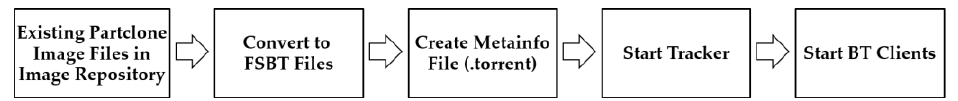
Figure 4. The flowchart about seeding and distributing FSBT files to all machines. FSBT: file system blocks transferring; BT: BitTorrent.